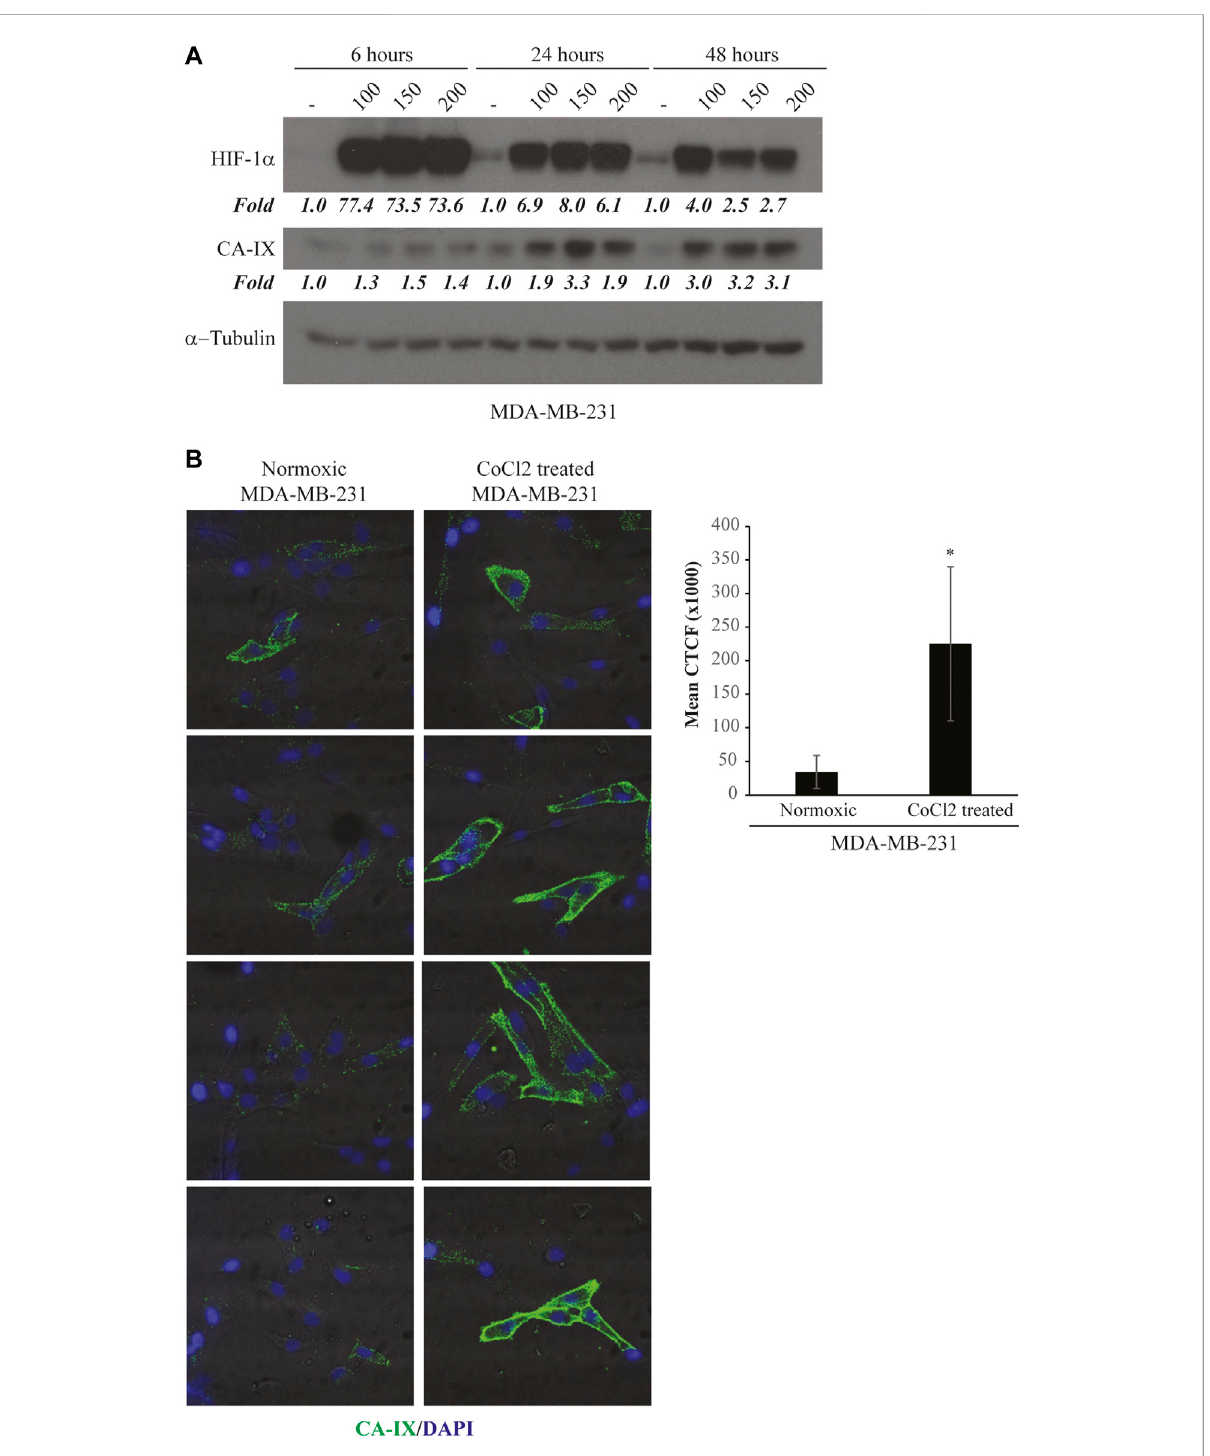
CoCl2-induced hypoxic phenotype. (A) Time and dose-response assay for CA-IX and HIF-1 α expression. MDA-MB-231 cells were treated with increasing concentrations of CoCl 2 (100 – 150 – 200 μ M) for 6, 24 or 48 h. Cell lysates were recovered and immunoblot analysis was performed to evaluate CA-IXandHIF-1 α expression; β -actin wasused tomonitorequal loading. Valuesbelowtheblotindicatethebandintensity quanti fi edbythe ImageJprogram.Signalshavebeennormalisedovertheloadingcontrolandexpressedrelativetothecorrespondentuntreatedpoint. (B)